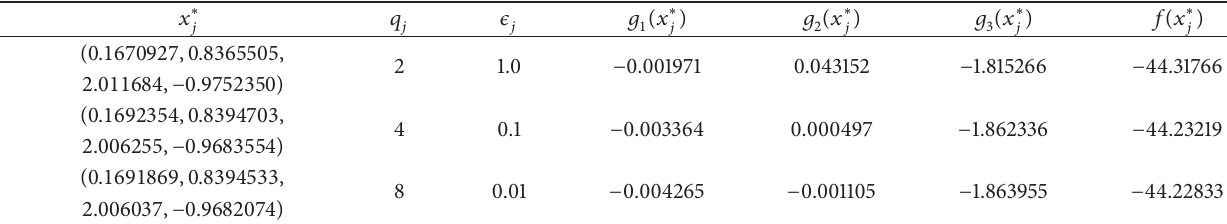
Table 6: Numerical results for Example 2 by Algorithm